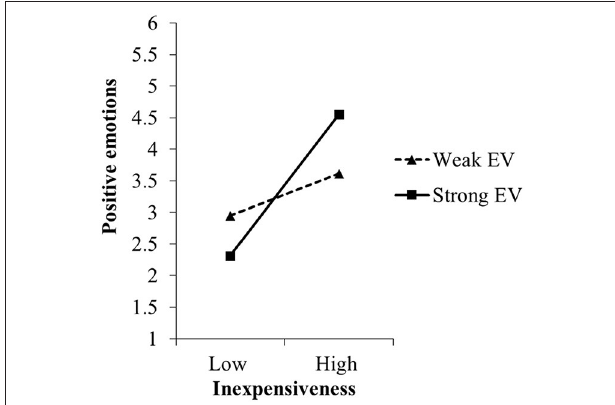
FIGURE 6 | Moderating effect of egoistic values (EV) on the relation between perceived inexpensiveness of and positive emotions toward nanophotonic lightbulbs in experiment IV, study 1. For the simple slope analyses, we used the estimates of step 2 of the regression analyses (c.f. Table 4